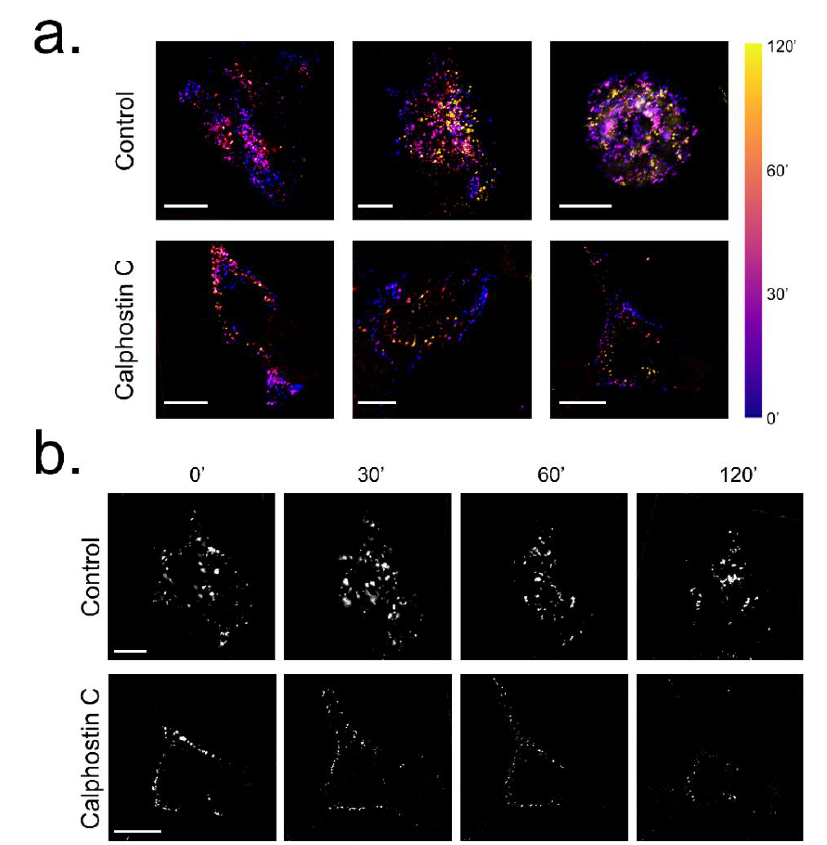
Figure 5. Influence of PKC inhibition on K V 1.5–HA–K V β 1.3 mobility in HEK293. ( a ) K V 1.5–HA labelled by fluorescence staining of live cell under control conditions and after PKC inhibition by calphostin C treatment and visualized at different times. Bar colors show the time from the calphostin-induced PKC inhibition as the beginning of the experiment. ( b ) Frames extracted at 0, 30, 60 and 120 min from Supplemental Video 1A for control and Supplemental Video 2B for calphostin C. Scale bar represents 10 μm in all images.